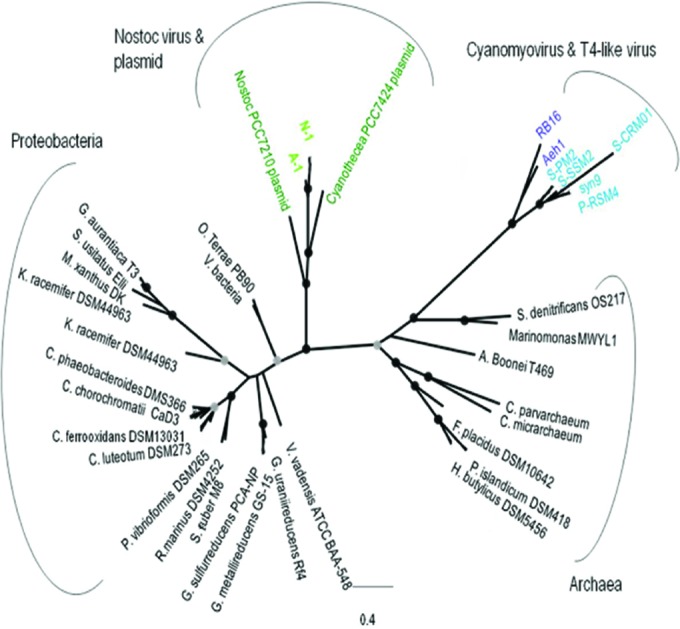
Unrooted ML phylogenetic tree of DNA Pol B protein sequences found in viruses, bacteria, and archaea. Bootstrap values of 90 to 100% (black circles) and 75 to 89 % (gray circles) are shown at the nodes. The sequence names are colored as follows: black, Bacteria and Archaea; light blue, marine cyanomyoviruses; dark blue, T4-like myoviruses; light green, Nostoc phages; dark green, cyanobacterial plasmid. The scale bar shows the number of amino acid substitutions per site.